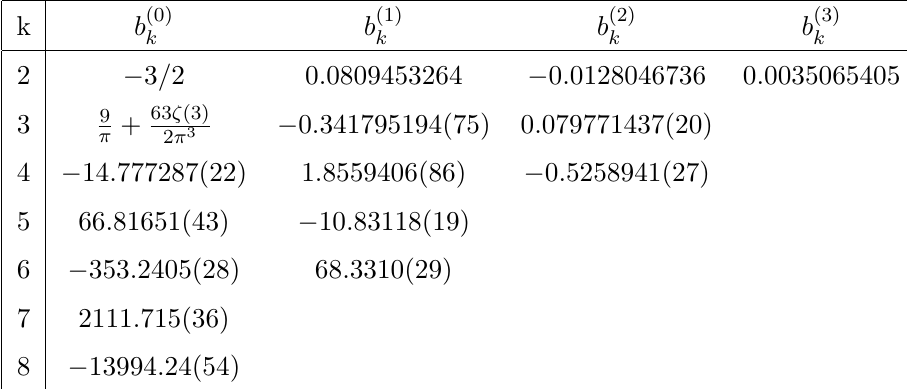
Table 8 . Values of the coe(cid:14)cients b ( n ) for the series expansion of the n th-derivative of the two- k point function e (cid:0) ( n ) ( (cid:0) m 2 ) as de(cid:12)ned in (3.10). These coe(cid:14)cients are the ones needed to get the 2 series of the physical mass M 2 up to O ( g 8 ) reported in eq. (3.11). The coe(cid:14)cients b (1) are determined numerically with arbitrary precision.